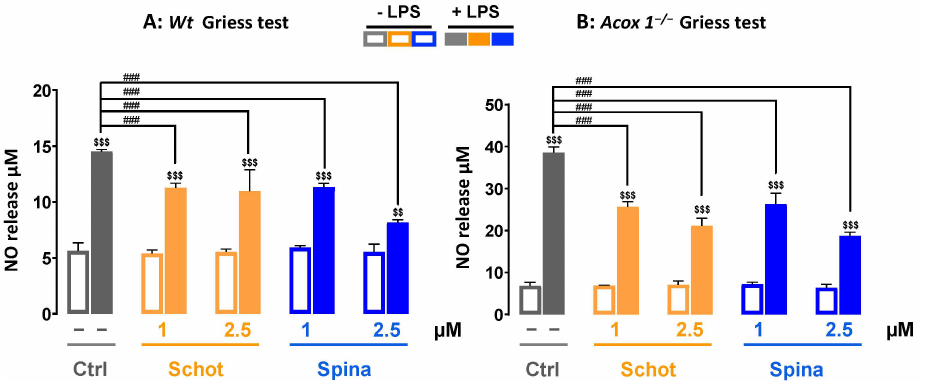
Figure 4. Effect of Schot and Spina on the NO production induced by LPS in the culture media of the Wt ( A ) and Acox1 − / − (B) BV-2 microglial cells assessed by the Griess test. Cells were incubated for 24h with Schot or Spina (1 or 2.5 µ M) in the absence or the presence of LPS (1 µ g/mL). All values are presented as means ± SD of two independent experiments performed in triplicate, with the statistical significance of the increase in mean signal indicated as ### p ≤ 0.01 compared to LPS and $$$ p ≤ 0.001 and $$ p ≤ 0.01 compared to the different treatments with or without LPS administration. Statistical significance was determined using two-way ANOVA followed by Tukey’s test for multiple comparisons.